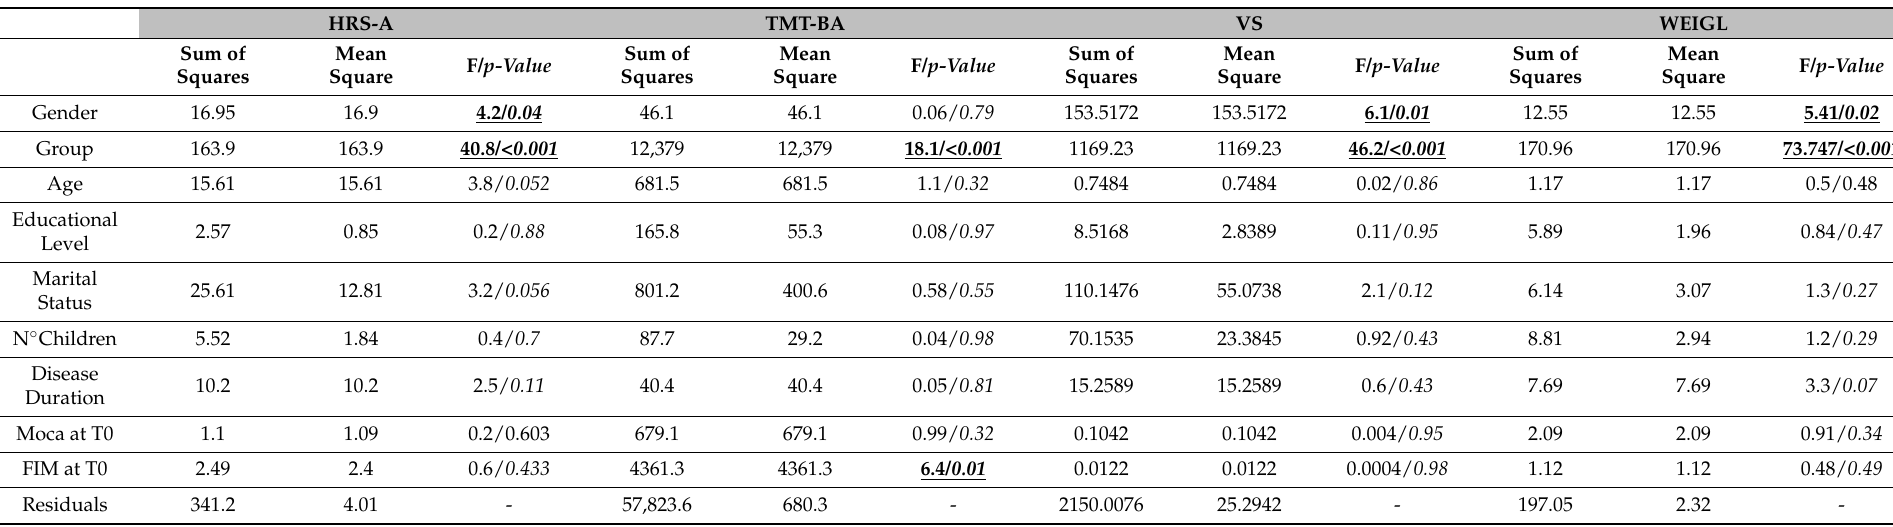
Table 2. Summary of regression analyses. Hamilton Rating Scale Anxiety (HRS-A); Trial Making Test (TMT B-A); Visual Research